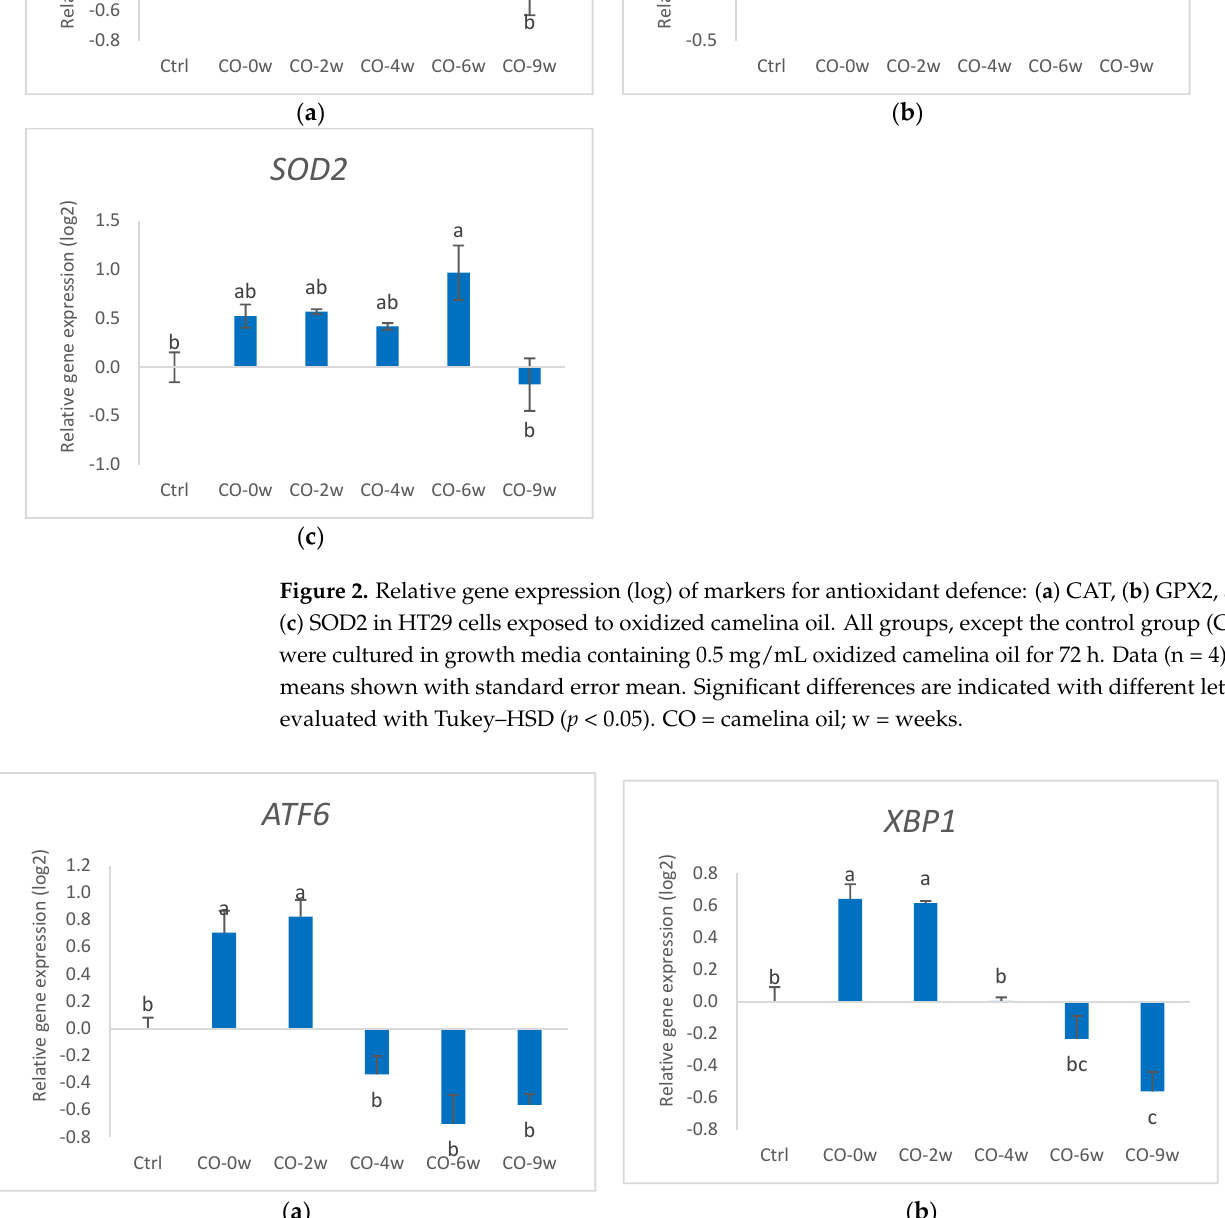
Figure 3. Relative gene expression (log) of markers for antioxidant defence: ( a ) ATF6 and ( b ) XBP1 in HT29 cells exposed to oxidized camelina oil. All groups, except the control group (Ctrl), were cultured in growth media containing 0.5 mg/mL oxidized camelina oil for 72 h. Data (n = 4) are means shown with standard error mean. Significant differences are indicated with different letters evaluated with Tukey–HSD ( p < 0.05). CO = camelina oil; w = weeks.